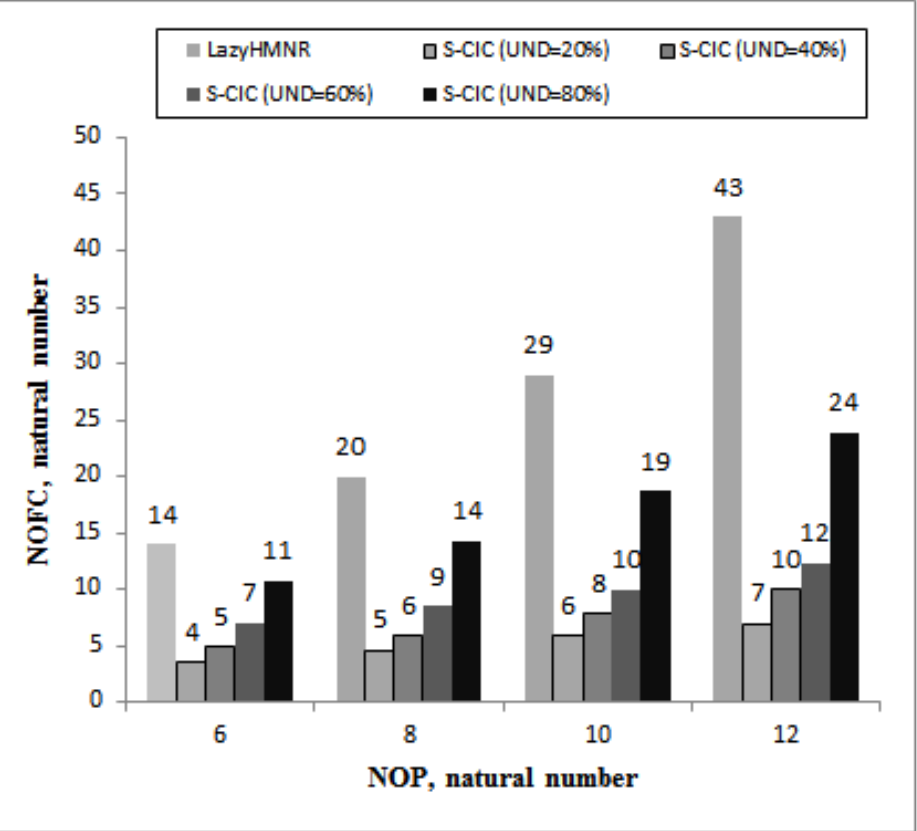
Figure 8. NOFC for the irregular